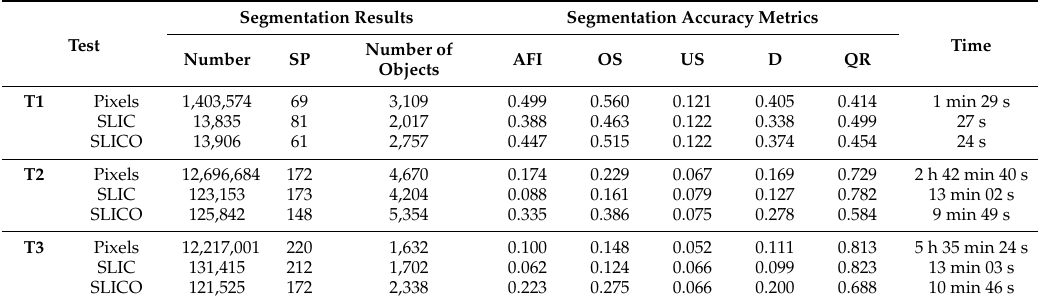
Table 5. Segmentation accuracy and computational time for the three test areas (T1 to T3) for multiresolution segmentation (MRS) using pixels, Simple Linear Iterative Clustering (SLIC), and SLICO superpixels, respectively. The number of initial pixels/superpixels, scale parameter (SP) and the final number of objects after applying ESP2 is depicted in the table. The segmentation accuracy measures used are Area fit index (AFI), Over-segmentation (OS), Under-Segmentation (US), Root mean square (D) and Quality rate (QR). Segmentation Results Segmentation Accuracy Metrics